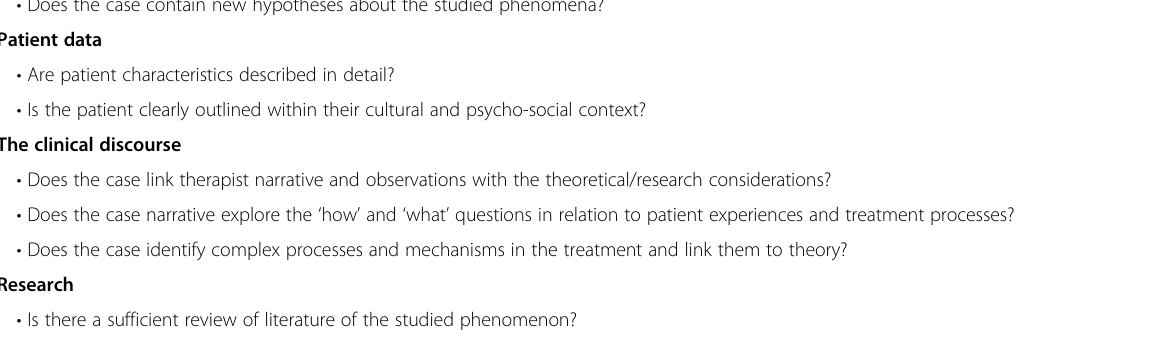
Table 13 Case Study Evaluation-tool (CaSE) purpose-based evaluative framework for systematic case studies.